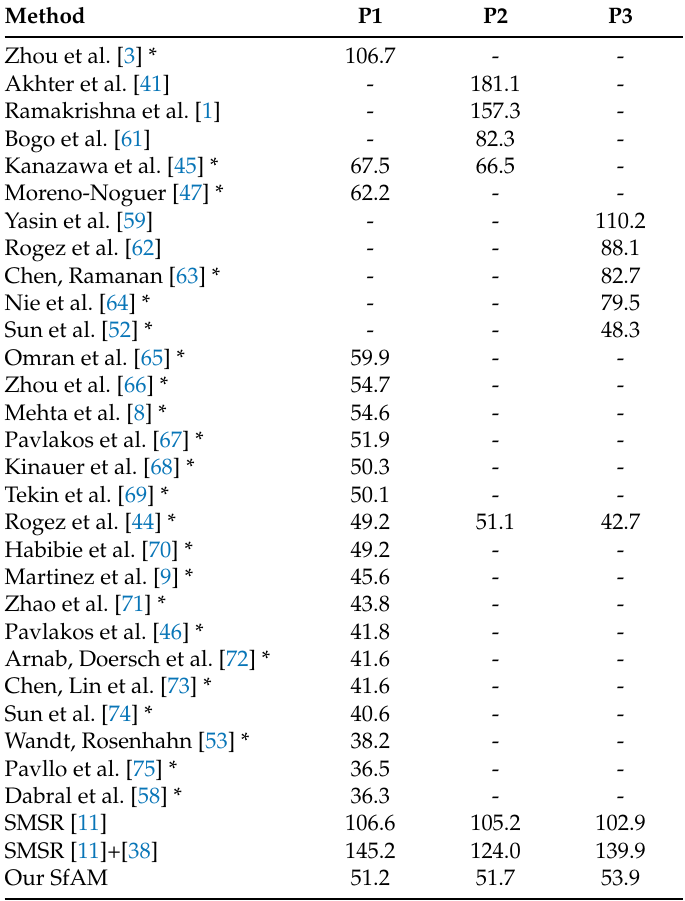
Table 1. The reconstruction error E 3 D of SfAM and previous methods on Human 3.6m dataset. “*” indicates learning-based methods which are trained on Human 3.6m [12]. We outperform all model-based approaches and reach very close to the tuned supervised learning techniques.